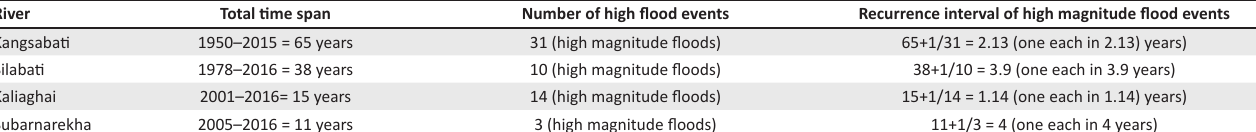
TABLE 1: High flood frequencies and their recurrence